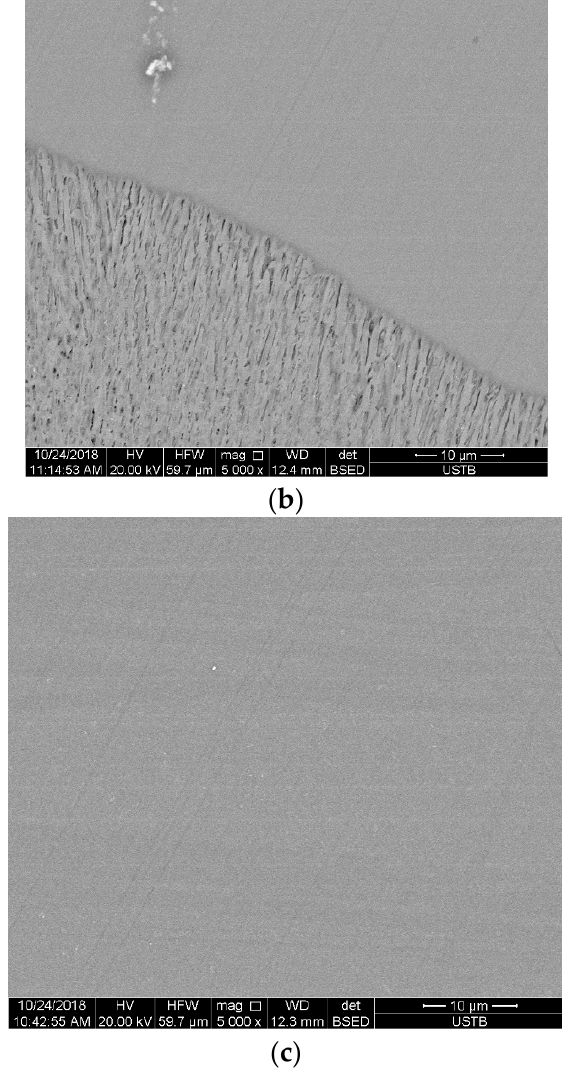
Figure 7. The micrographs of MoO 3 -free samples: ( a ) low-magnification micrograph; enlarged micrographs of ( b ) zone 1 and ( c ) zone 2.